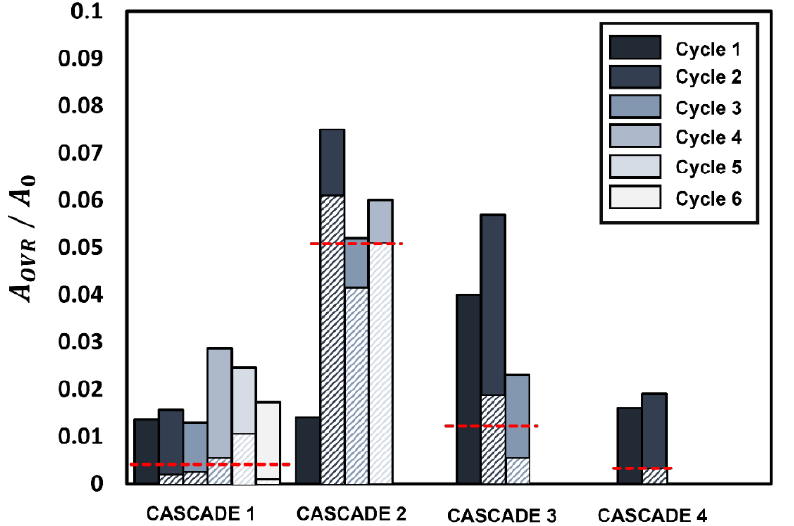
Figure 6. The variation of the normalized overlap area of the rupture sites ( A OVR / A 0 ) between successive cycles with each cascade. Solid bars represent the rupture site area for each cycle while shaded bars represent the percentage overlap between successive cycles. The horizontal red dotted lines represent the average overlap for each cascade.